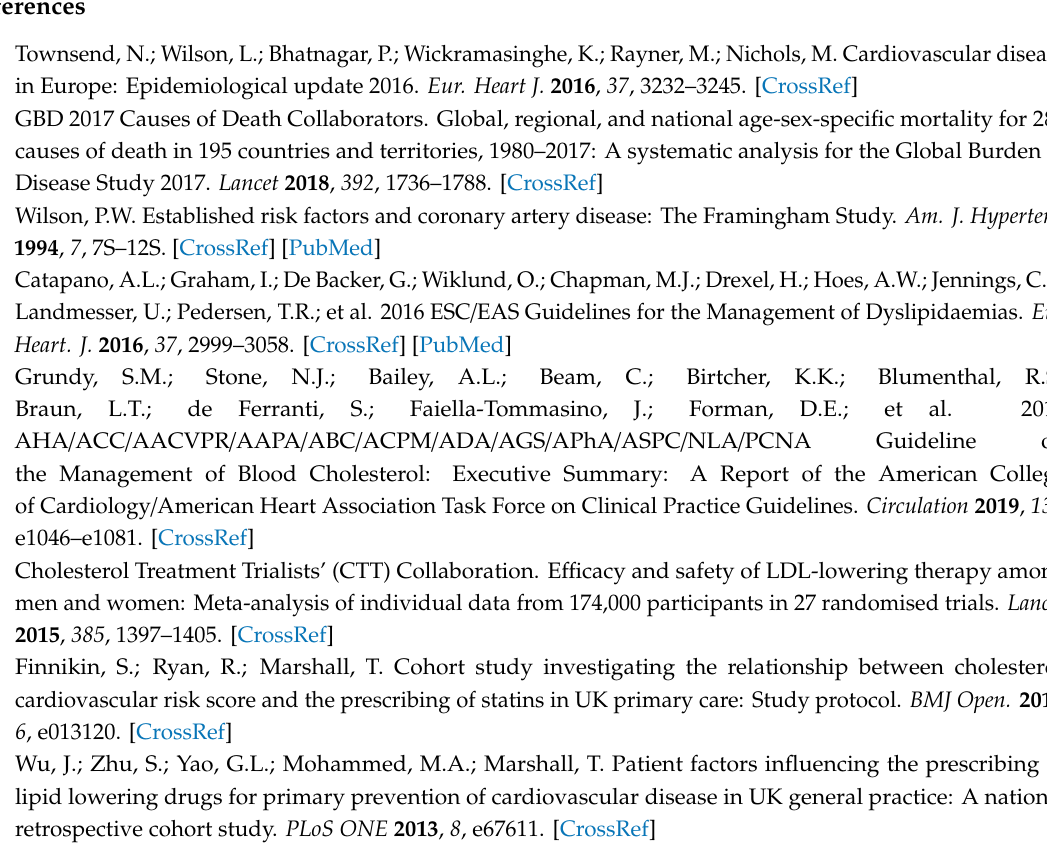
Table S1: Operationalization of the cardiovascular risk categories according to the 2016 European Society of Cardiology Guidelines, Table S2: Definitions of morbidities, Table S3: Description of patients for whom statin initiation is recommended, stratified by guideline concordance of the treatment